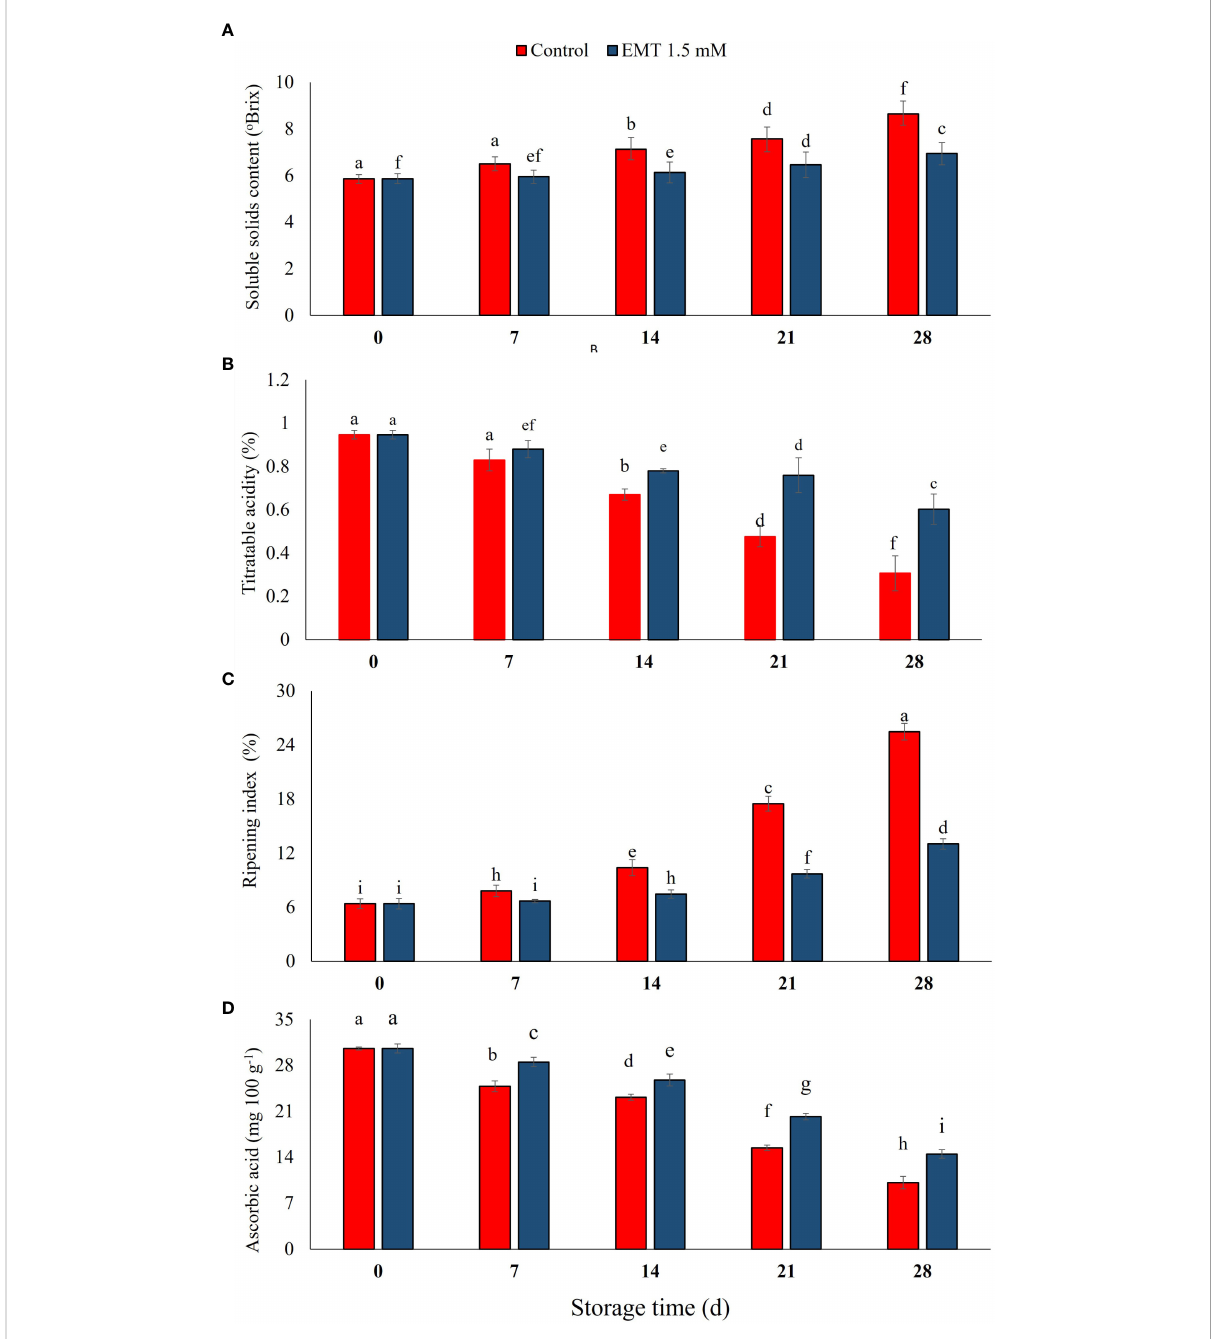
FIGURE 2 Effect of EMT treatment on soluble solids content (A) , titratable acidity (B) , ripening index (C) , and ascorbic acid (D) of papaya fruits during cold storage. Data collected from the mean of three replicates, and vertical bars indicate the standard error of the means. Mean values with different letters show signi fi cant differences, and those with the same letters show no statistical difference according to the least signi fi cant difference test ( P <